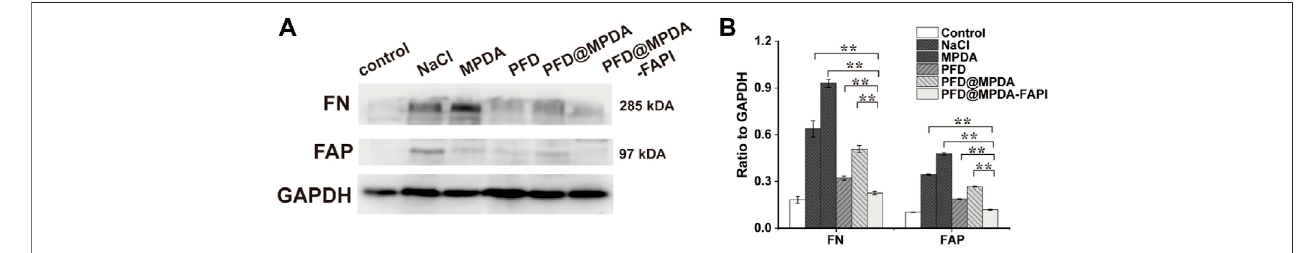
FIGURE 8 | (A,B) WB results of FN and FAP among different treatment groups (* p <